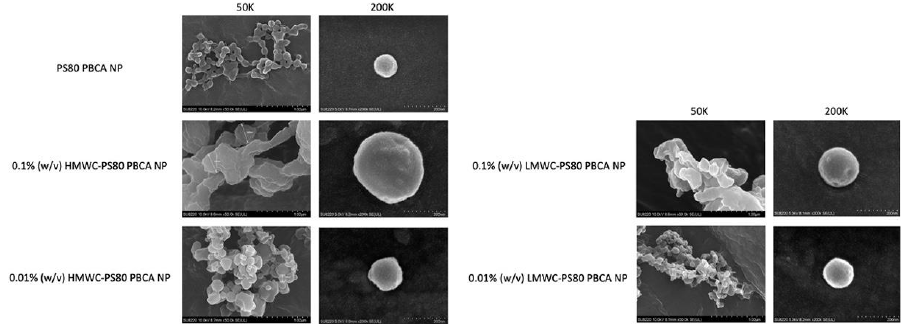
Figure 3. FE-SEM micrographs of PS80 PBCA NP, 0.1% ( w / v ) HMWC-PS80 PBCA NP, 0.1% ( w / v ) LMWC-PS80 PBCA NP, 0.01% ( w / v ) HMWC-PS80 PBCA NP, and 0.01% ( w / v ) LMWC-PS80 PBCA NP. 50,000x (solid samples) and 200,000x (aque- ous samples) magnification. The shape of the nanoparticles were spherical in solution; the largest nanoparticle size was obtained when 0.1%, HMWC was used.